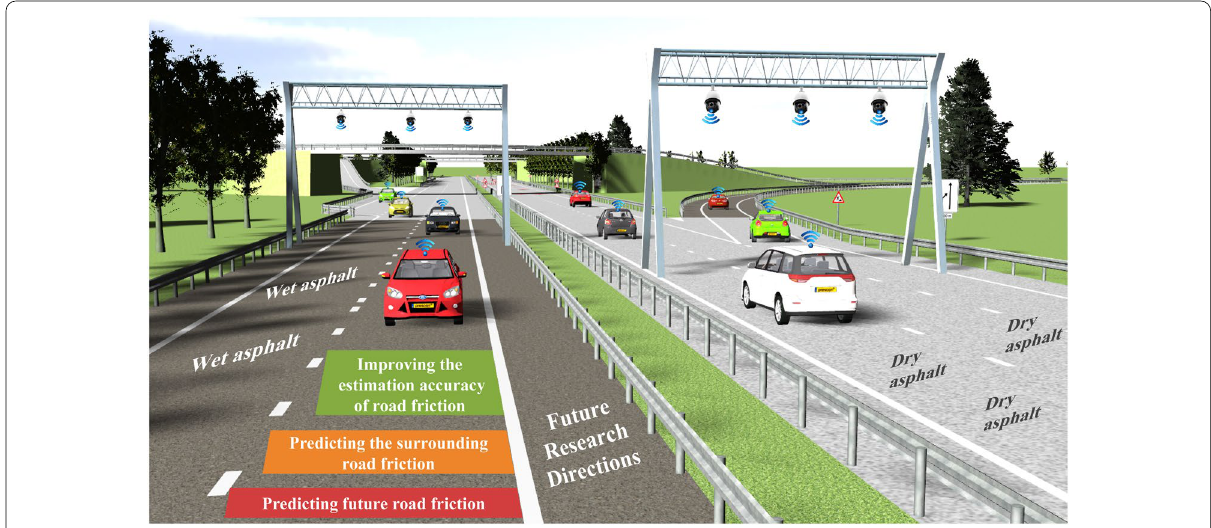
Figure 6 Future research directions on TRFC